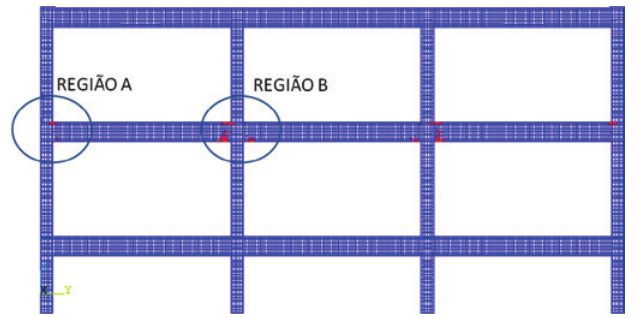
Figura 10 Pontos de fissura e esmagamento do concreto no instante da ruptura (1º Modelo) e no instante do incremento final de carregamento (2º Modelo)